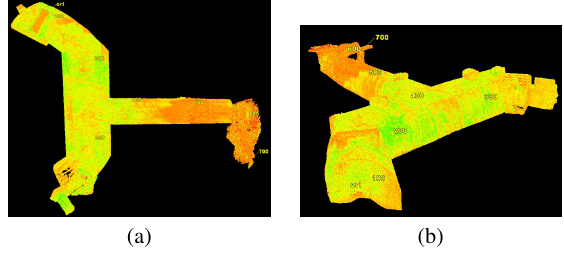
Figure 7. Top view (a) and perspective view (b) of the deci- mated 3D model of Impossible bastion derived from TLS mea- surements. Intensity data are mapped onto the model with false color scale. Numbers denote traverse stations.